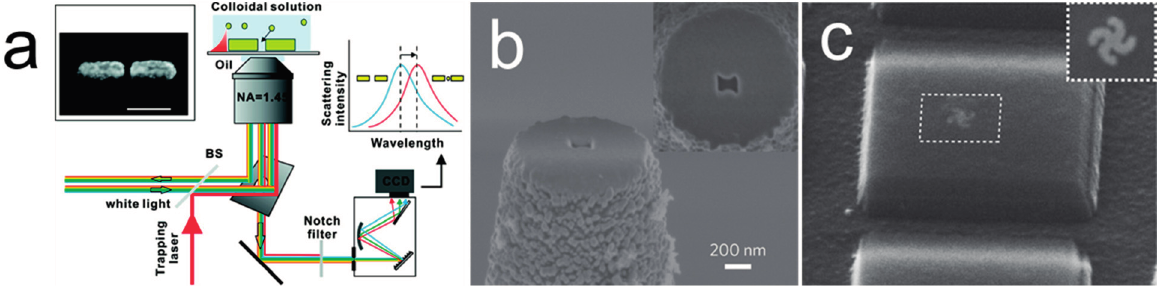
Figure 13. Plasmonic tweezers for trapping and rotating nanoentities. ( a ) Schematic diagram of the setup of the plasmonic tweezers trapping and detecting 10 nm Au particles [94]; With permission from [94]; ( b ) SEM image of an 85-nm-gap bowtie